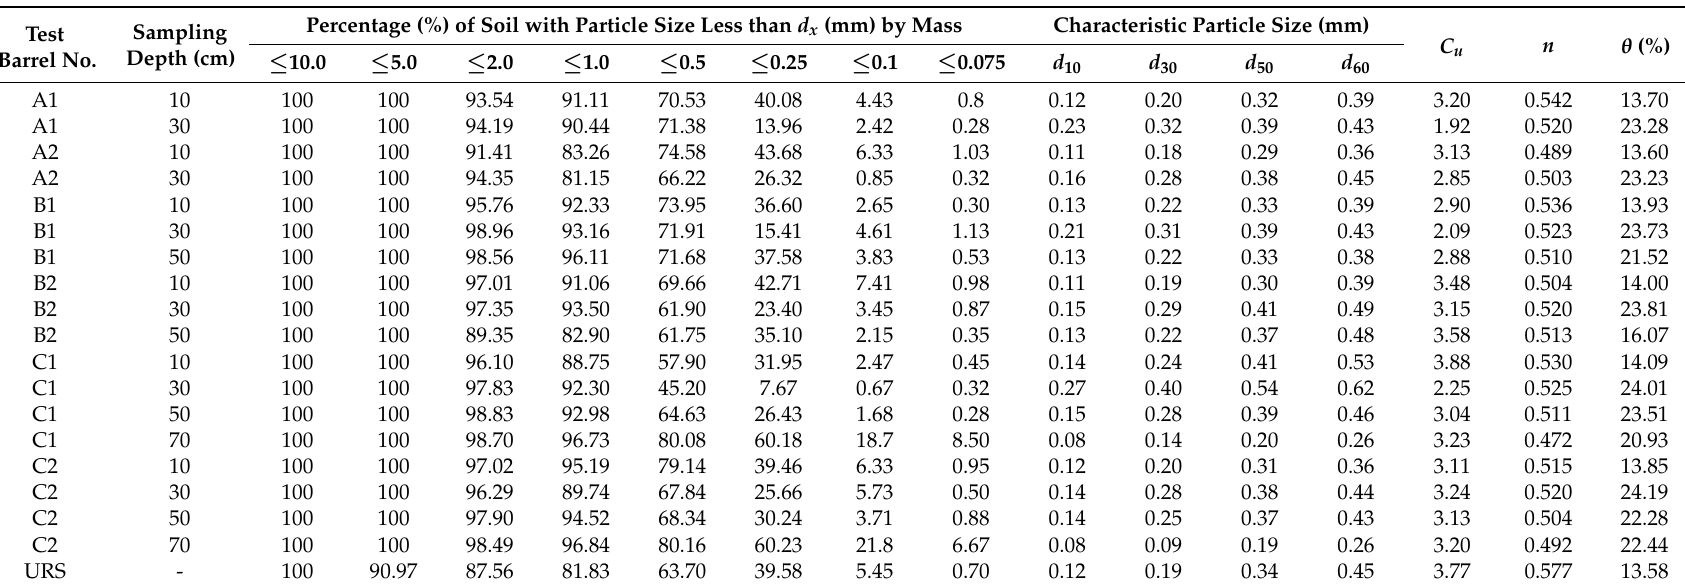
Table 1. Results of the reclaimed soil particle size analysis after a one-year management